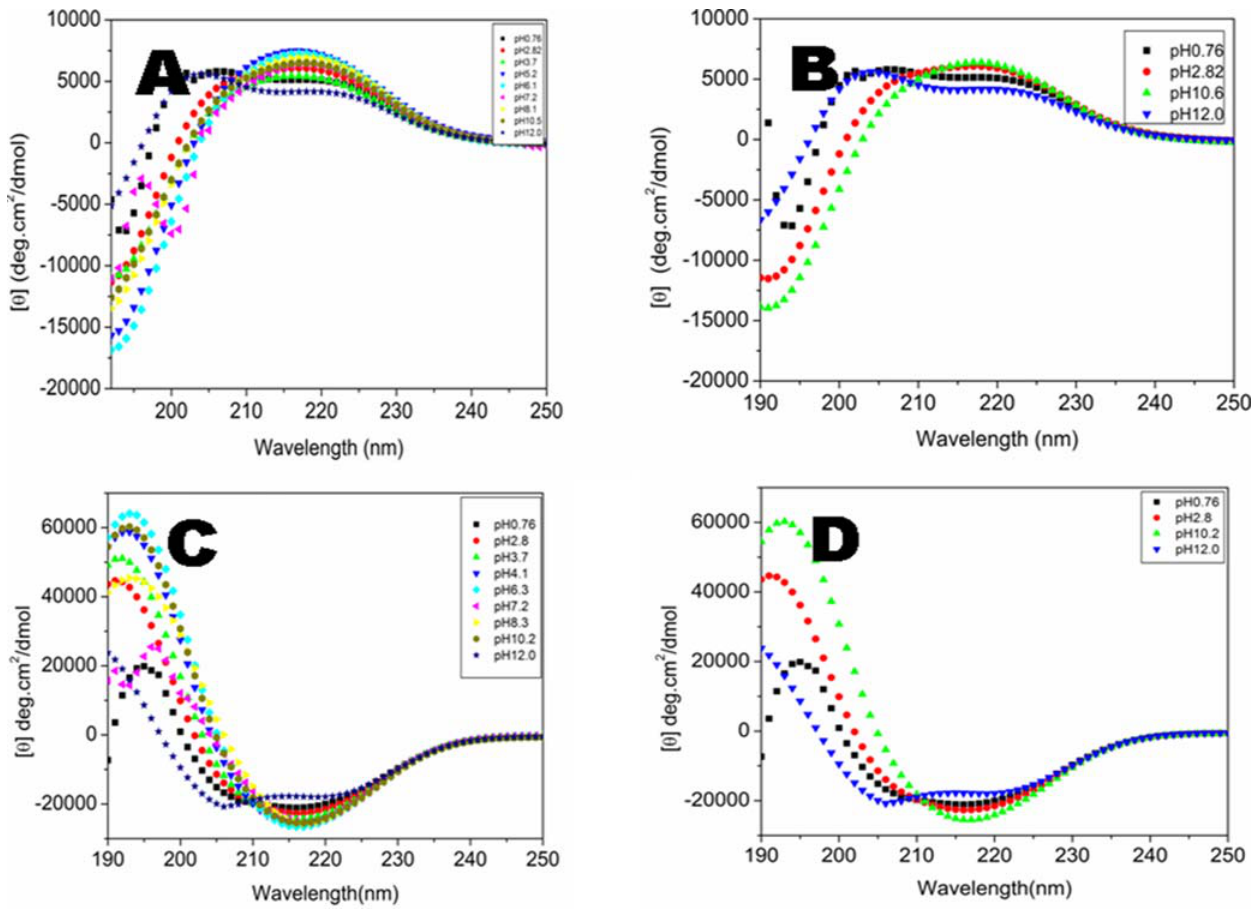
Figure 7. pH effect on the d-EAK16 and l-EAK16 structural transition. The d-EAK16 was incubated in solutions of various pH range from 0.76–12.0. A) The structural behavior from the d-EAK16 spectra in different pH showed the variations. The structures were different at pH0.76, pH12.0 and neutral pH. The d-EAK16 beta-sheet content is fairly similar at pH 5.2, pH6.1, pH7.2, pH8.1 and pH10.5. The d-EAK16 at pH2.8 and pH10.5 exhibits somewhat different spectra. There seemed to be either an intermediate structure or mixture with both alpha-helix and beta-sheet. B) The d-EAK16 spectra suggest four variations of structures at pH0.76, pH2.8, and pH10.5 and pH12.0. C) The structural behavior from l-EAK16 spectra in different pH showed variations. D) The l-EAK16 spectra suggest four variations of structures at pH0.76, pH2.8, pH10.2 and